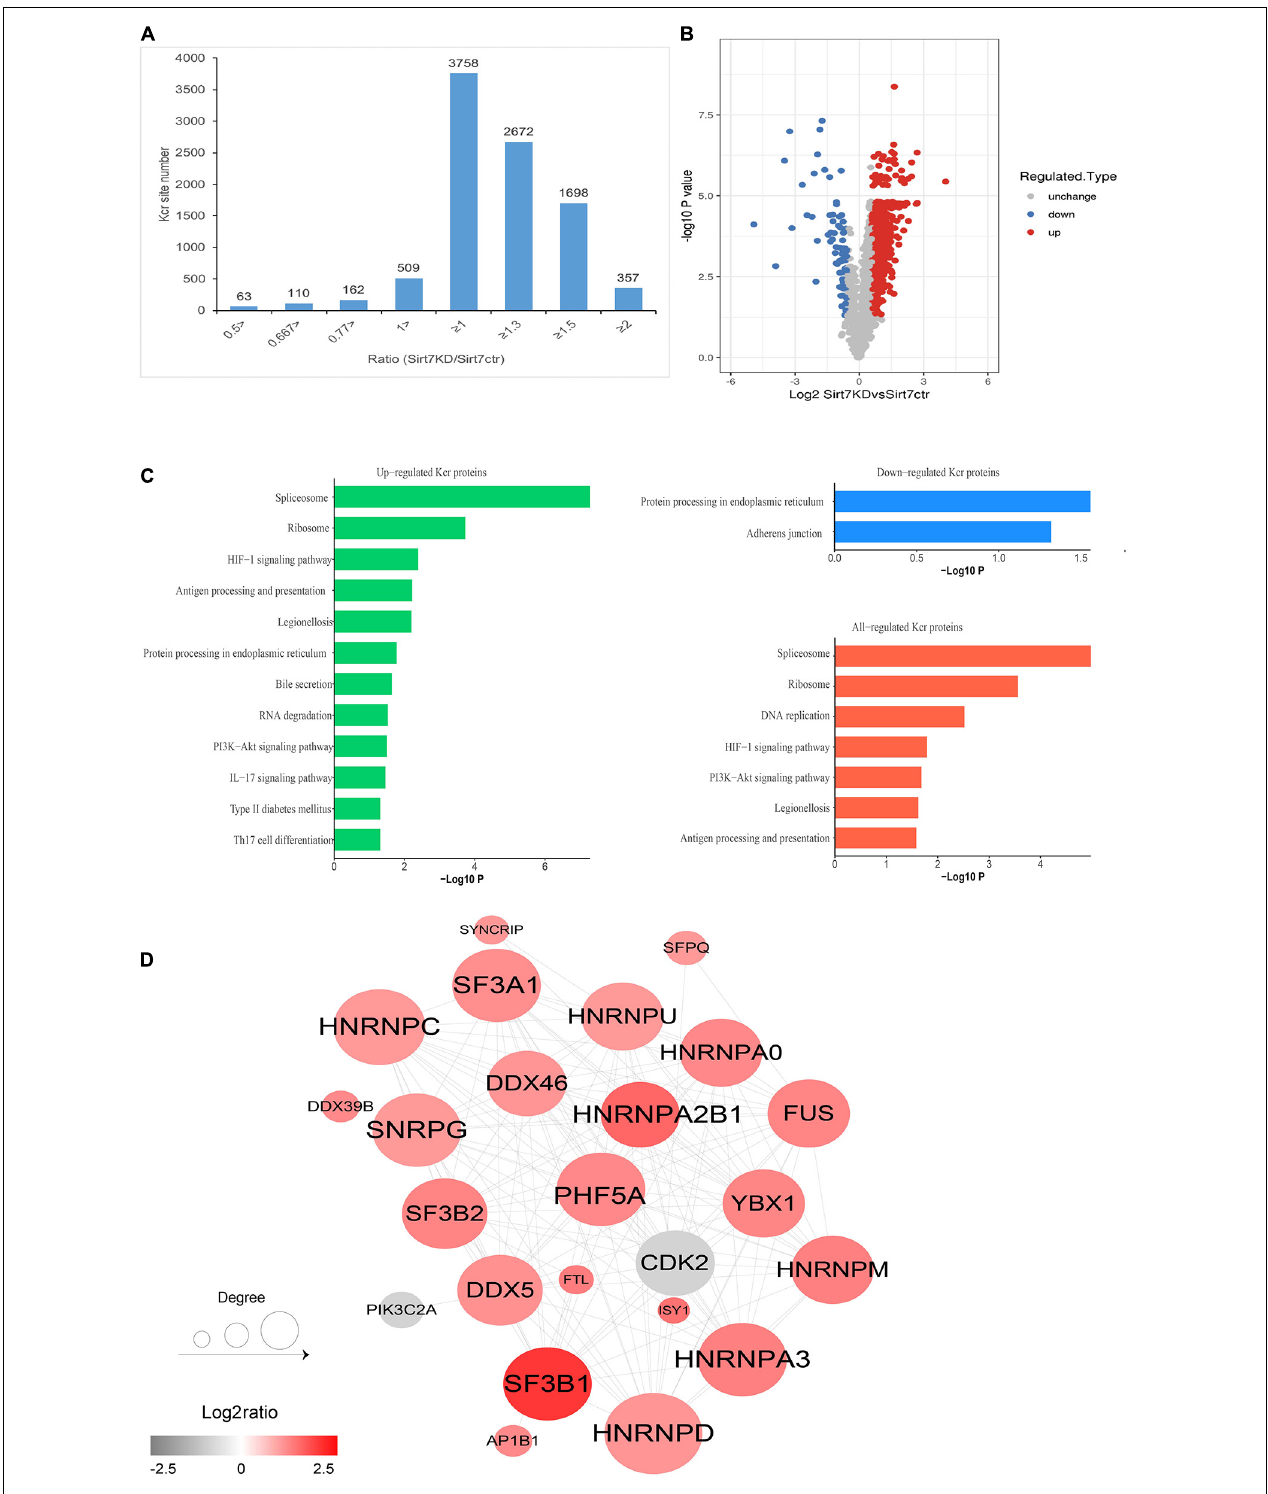
FIGURE 5 | Quantification analysis of crotonylome in response to SIRT7 KD. (A) Histogram showing the ratio distribution of quantifiable Kcr sites between WT and SIRT7 KD senescence 2BS fibroblast. (B) Volcano plot showing the differential expression profile of Kcr protein in WT and SIRT7 KD senescence 2BS fibroblast. (C) Bar graphs showing the KEGG pathway associated with all identified, upregulated, and downregulated Kcr proteins. (D) Protein–protein interaction network of SIRT7-regulated Kcr proteome based on the STRING database.